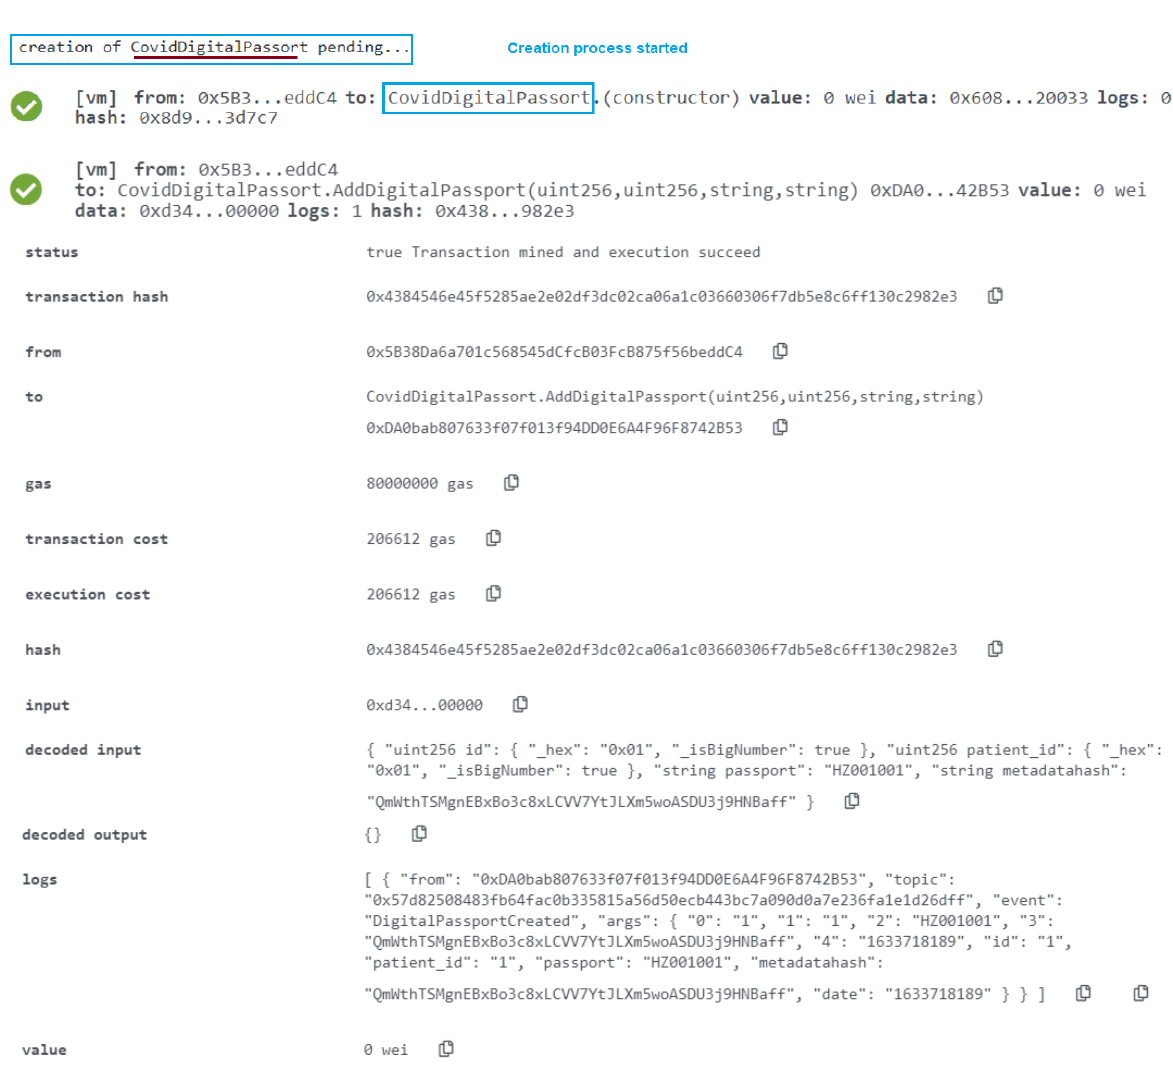
Figure 10. Save COVID ‐ 19 Patient’s detail in the blockchain ledger.